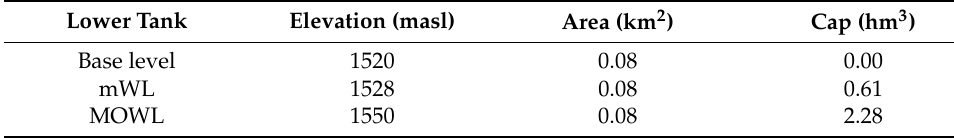
Table 3. Lower Tank Elevations-Capacities-Areas